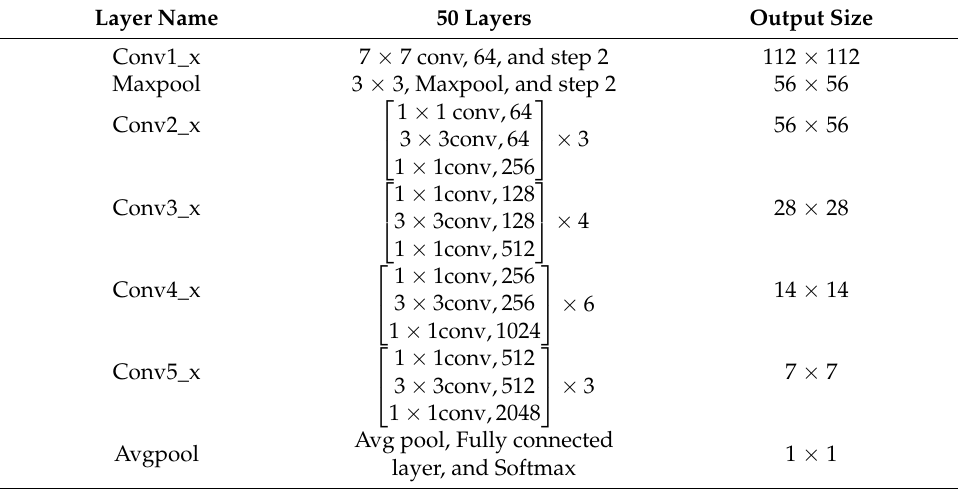
Table 1. ResNet50 network